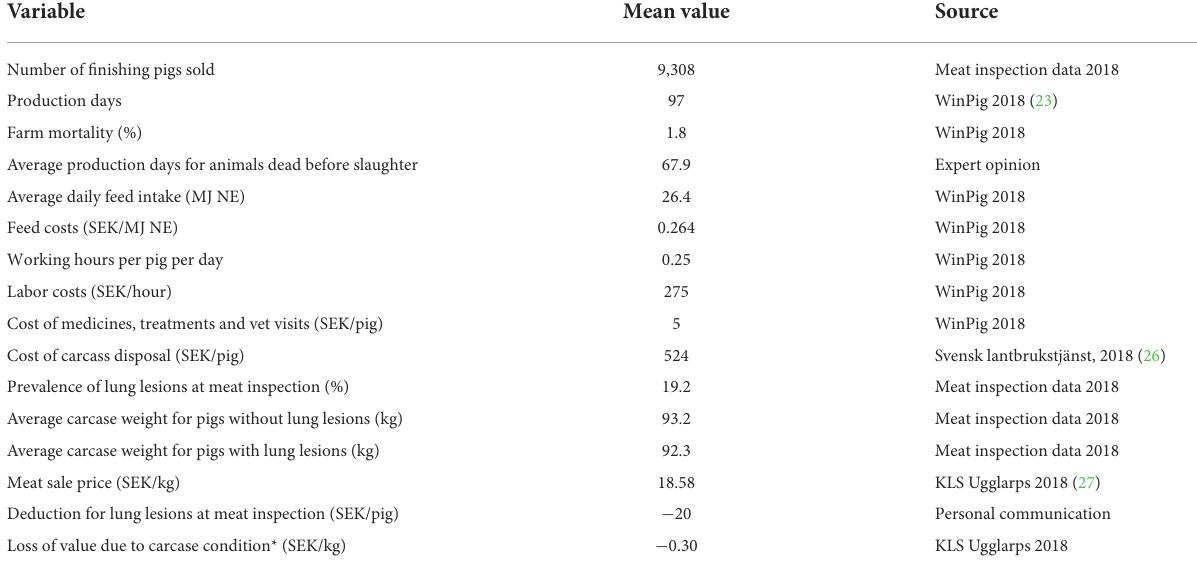
TABLE 1 Summary of variables included in the baseline farm model. Costs shown are associated with the finishing phase of production on a yearly basis. Variable